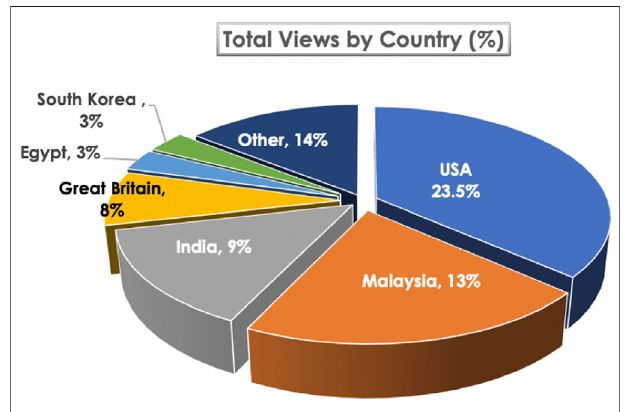
FIGURE 8 | Geographical distribution of YouTube views.